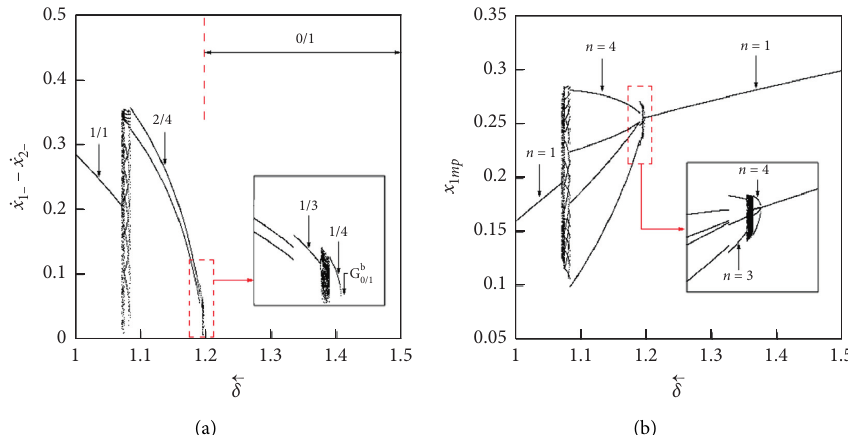
� 0 . 9. (a) Impact bifurcation diagram; ( 0/1 ) ∩ ( 1/1 ) longitudinally at ω